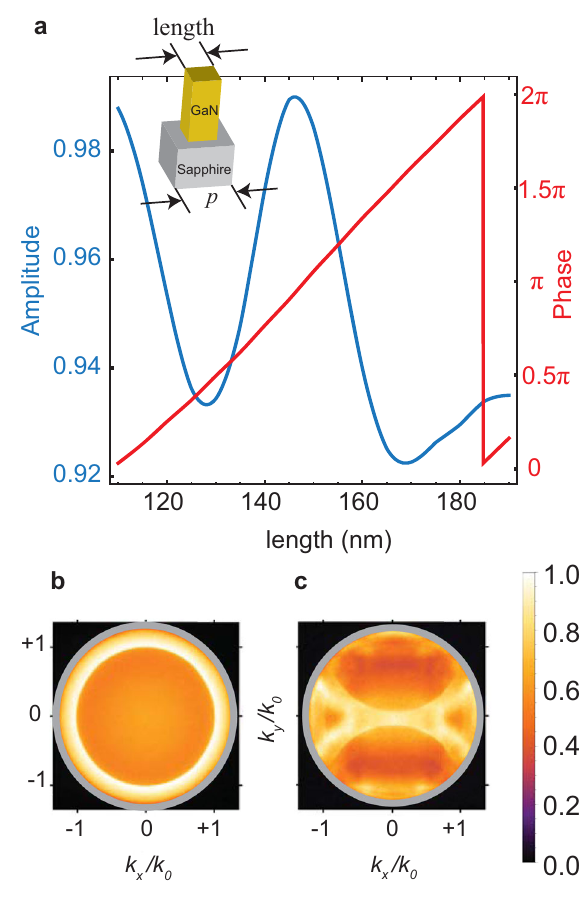
Fig. 1 Design principles for light-emitting metasurfaces. a The transmitted amplitude (blue) and relative phase (red) of a plane wave impinging upon a GaN nanopillar from the top at a wavelength of 560 nm (Methods). The microperiod, p , of the structure is 250 nm. b Normalized intensity of measured unpolarized photoluminescence (PL) from the InGaN/GaN thin fi lm as a function of normalized momenta k intensity of measured unpolarized PL from an emitting 1D beam de fl ector, designed to impart a momentum of k y ¼ þ 0 : 8 k function of normalized momenta k x = k 0 and k y = k 0 . The gray ring corresponds to NA =